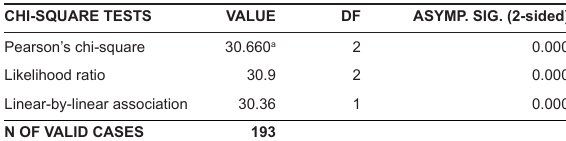
TABLE 5 Chi-square tests on the knowledge of HIV/AIDS status of staff